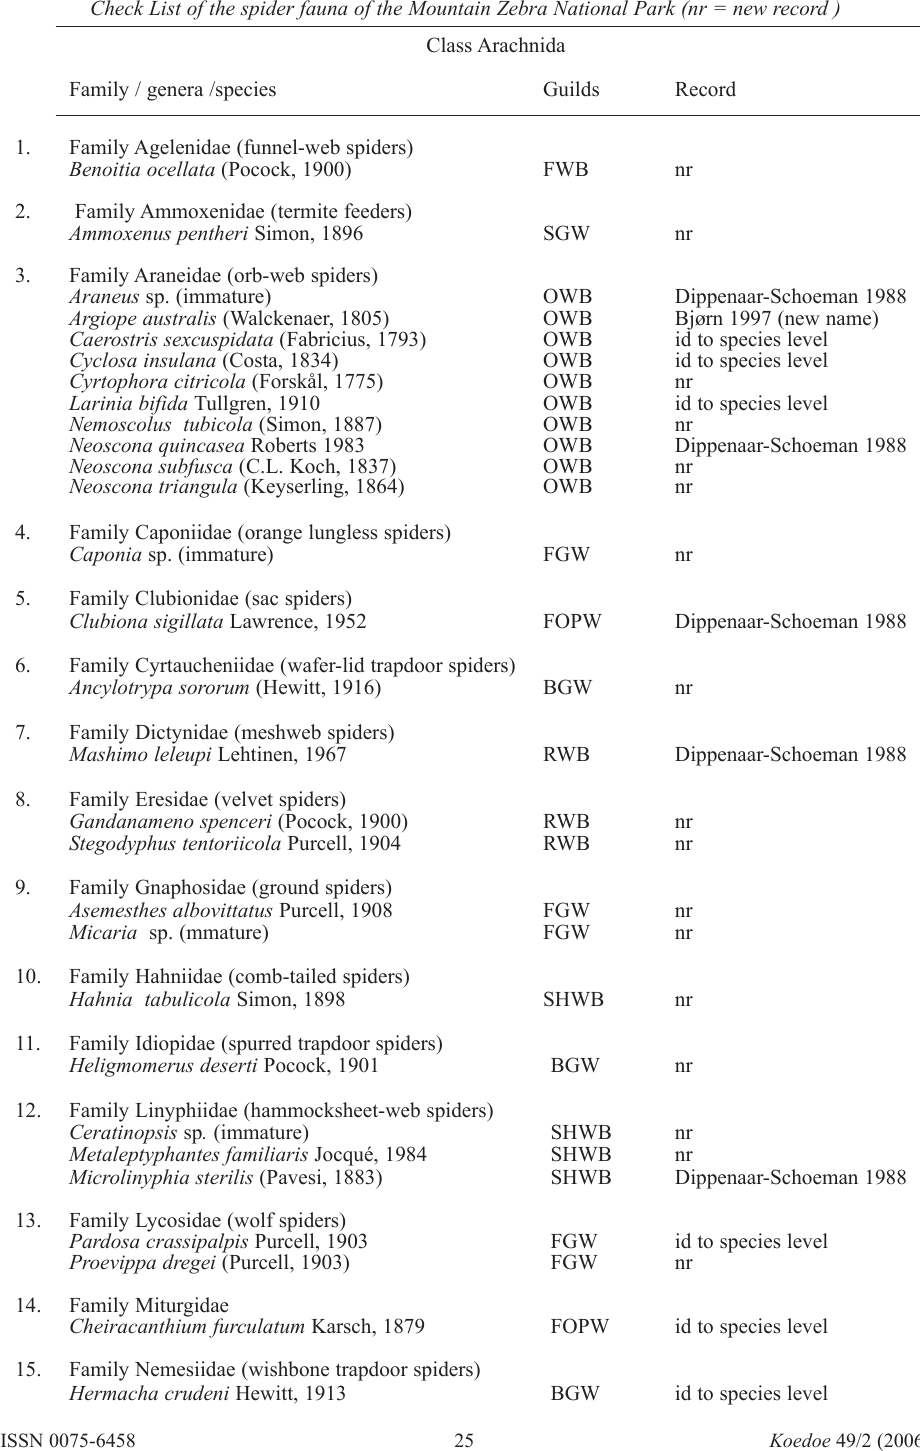
Check List of the spider fauna of the Mountain Zebra National Park (nr = new record )